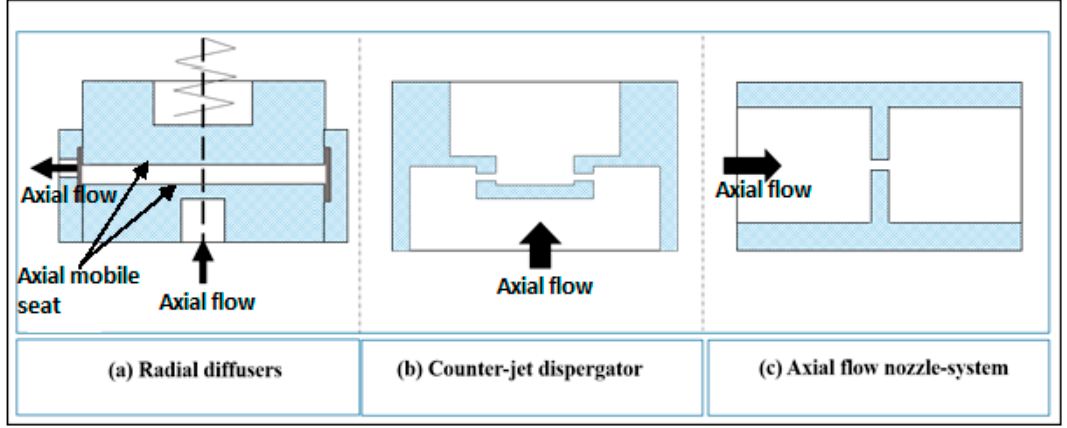
Figure 1. High-pressure homogenization (HPH) disruption units in ( a ) radial-diffusers; ( b ) counter-jet-dispergator: jet-dispergator; and ( c ) axial flow nozzle-system. Reproduced with permission from Gall et al., Processes; published by MDPI, 2016 [28].